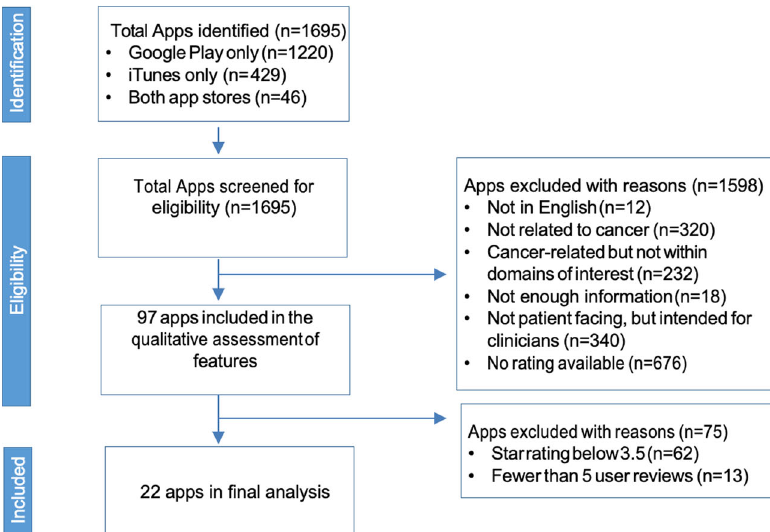
Fig. 1 Mobile app selection process. Out of 1695 apps identi fi ed, 22 apps were eligible based on exclusion criteria outlined in fi gure.